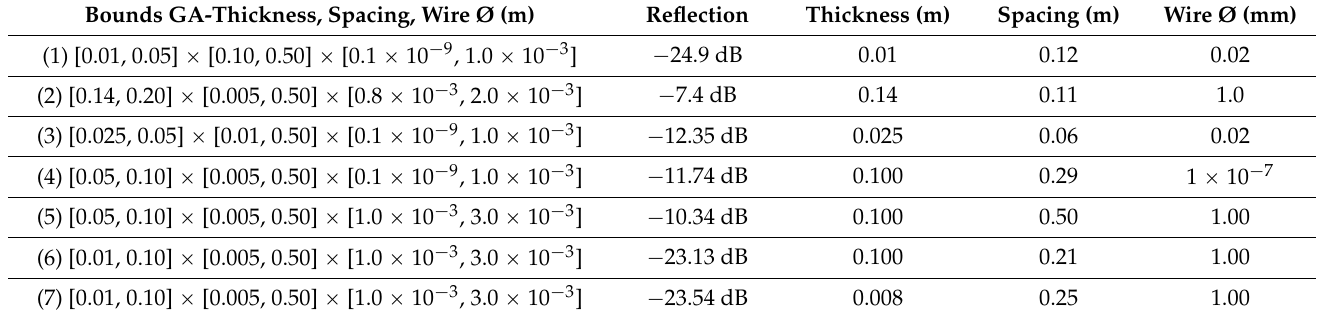
Table 2. Optimal parameters obtained by looking for in different parameter bounds. Fitness as Equation (29). Bounds GA-Thickness, Spacing, Wire Ø ( m )